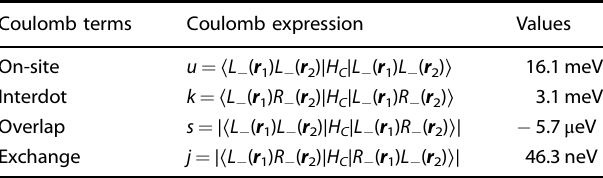
Fig. 2 Exchange splitting calculated with only single-dot s-orbitals. a Dependence of the ground singlet ( S = 0) and triplet ( S = 1) energy levels on the valley phase difference between the two dots (with ϕ R = 0). For a smooth interface, the exchange interaction is E J = 67 neV with ∣ = ∣ Δ ∣ = 0.1 meV for the chosen double dot parameters. b shows the states of ground singlet and triplet for a general ϕ . Panels c and ∣ Δ L R d illustrates state dressing for phase difference ϕ = 0 and ϕ = π , respectively. The ground singlet energy level ( E g , s ) for smooth interface is the zero energy reference. Table 1. Relevant Coulomb matrix elements for two electrons in a double quantum dot, which show a clear hierarchy in their magnitudes.